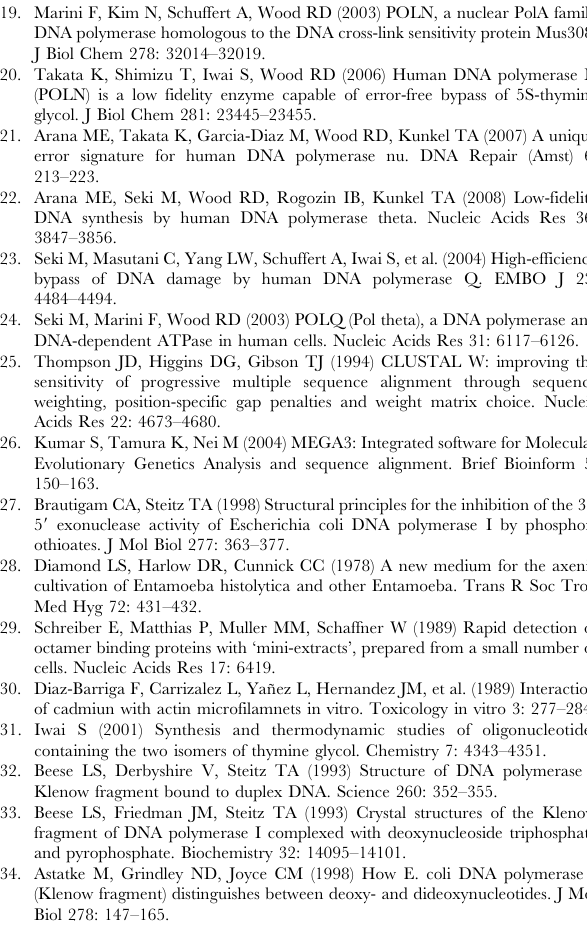
Figure S1 Optimal activity conditions of EhDNApolA. To determine the optimal conditions for DNA polymerization, 60 fmol of EhDNApolA were incubated with 200 fmol of nicked substrate for 10 min under varying experimental conditions. DNA polymerase activity was measured by the extension of a 24 mer primer to a 45mer product (A) Effect of salt on DNA poly- merization activity. Lane1 corresponds to negative control with no polymerase, lane 2 no added salt salt, lanes 3 to 8 NaCl concentrations from 12.5 mM to 400 mM (B) MgCl2 dependence of EhDNApolA activity. The values were normalized to 100% as the higher polymerization value and the subsequent values were calculated as a relative percentage. The solid bars represent the relative percentage of polymerization. (C) pH influence on DNA polymerization activity (D) Temperature dependence of EhDNA- polA activity. Found at: doi:10.1371/journal.pntd.0000786.s001 (0.14 MB TIF) Figure S2 mRNA expression profiles of the EhDNApolA gene. RT-PCR analysis of EhDNApolA (Upper panel) in comparison to actin (lower panel). Amplification products using isolated RNA treated with Reverse Transcriptase (RT + ) (lanes 1 to 3) or with- out Reverse Transcriptase (RT -) (data not shown) were run on a 1% agarose gel and stained with ethidium bromide. The densitometric analysis of the RT-PCR product corresponding to the actin gene was designated as 100%. The EhDNApolA gene is